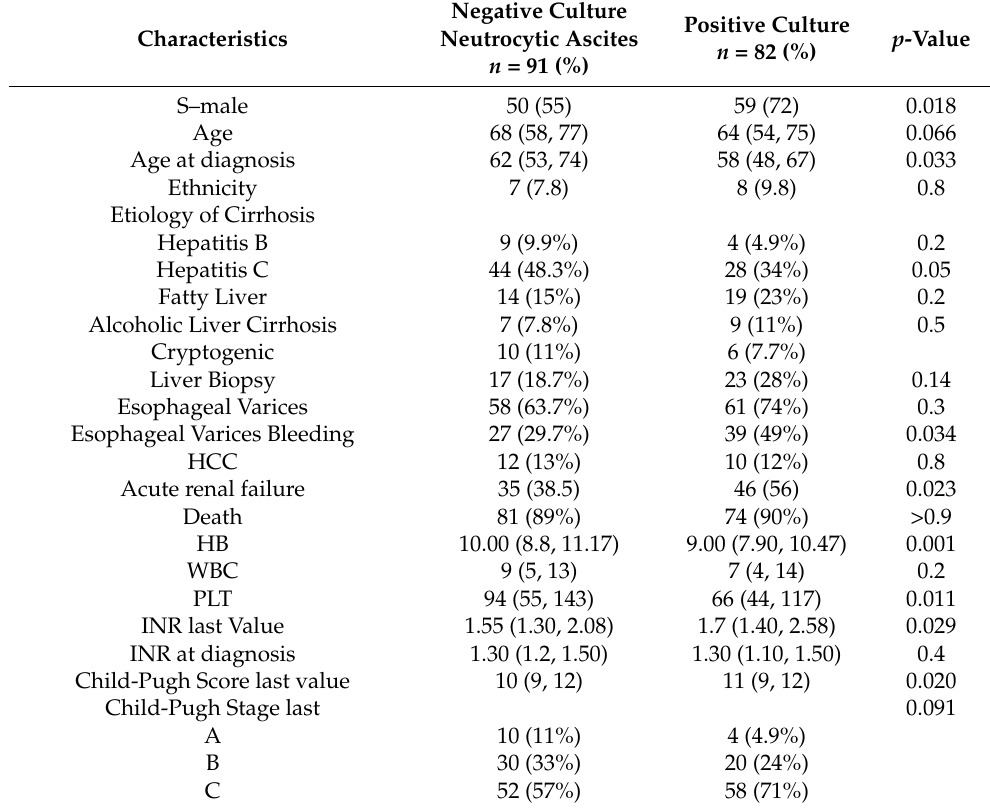
Table 2. Demographic and clinical characteristics of patients with positive and negative